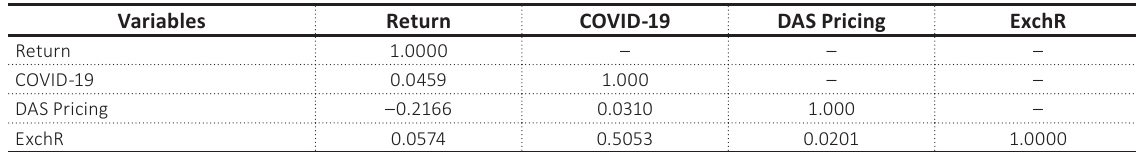
Table 2. Joint test for skewness/kurtosis tests for normality